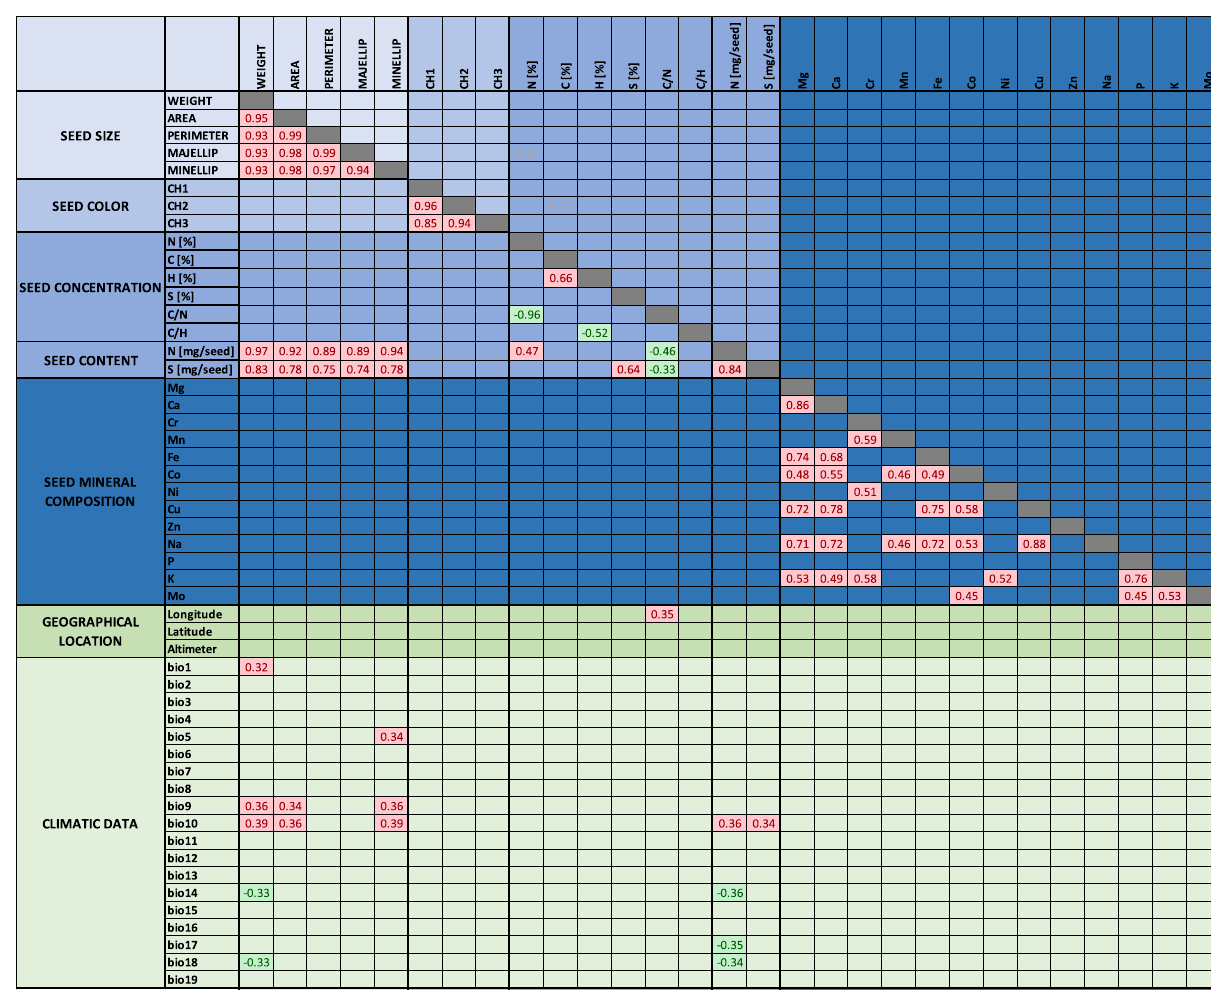
Figure 1. Correlation matrix between Medicago seed traits, and in relation to their geographical locations and climatic data. Only Pearson correlation coefficients (PCC) with adjusted p-values below 5% are indicated after BH procedure to control false discovery rate. Red color indicates PCC above 0.2 and green color indicates PCC below − 0.2. Longitude is expressed in degrees with negative degrees representing west and positive degrees representing east. Latitude is also expressed in degrees with negative degrees representing south and positive degrees representing north. Climatic data are from WorldClim. BIO1 annual mean temperature, BIO2 mean diurnal range, BIO3 isothermality, BIO4 temperature seasonality, BIO5 max temperature of warmest month, BIO6 min temperature of coldest month, BIO7 temperature annual range, BIO8 mean temperature of wettest quarter, BIO9 mean temperature of driest quarter, BIO10 mean temperature of warmest quarter, BIO11 mean temperature of coldest quarter, BIO12 annual precipitation, BIO13 precipitation of wettest month, BIO14 precipitation of driest month, BIO15 precipitation seasonality, BIO16 precipitation of wettest quarter, BIO17 precipitation of driest quarter, BIO18 precipitation of warmest quarter, BIO19 precipitation of coldest